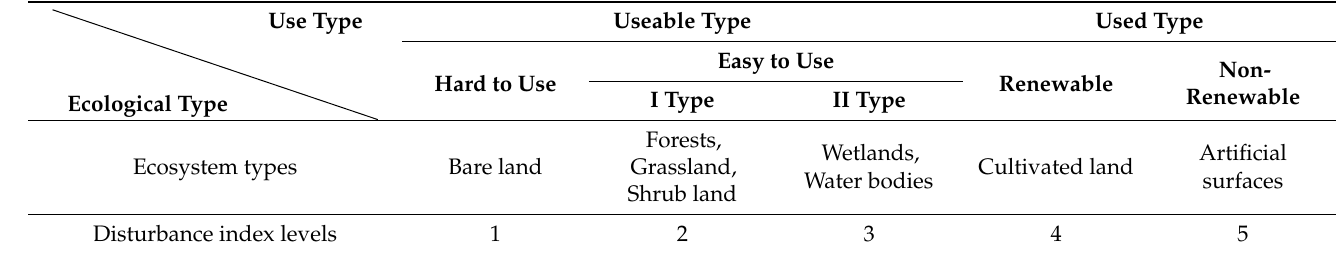
Table 1. The disturbance degree of human activities on different